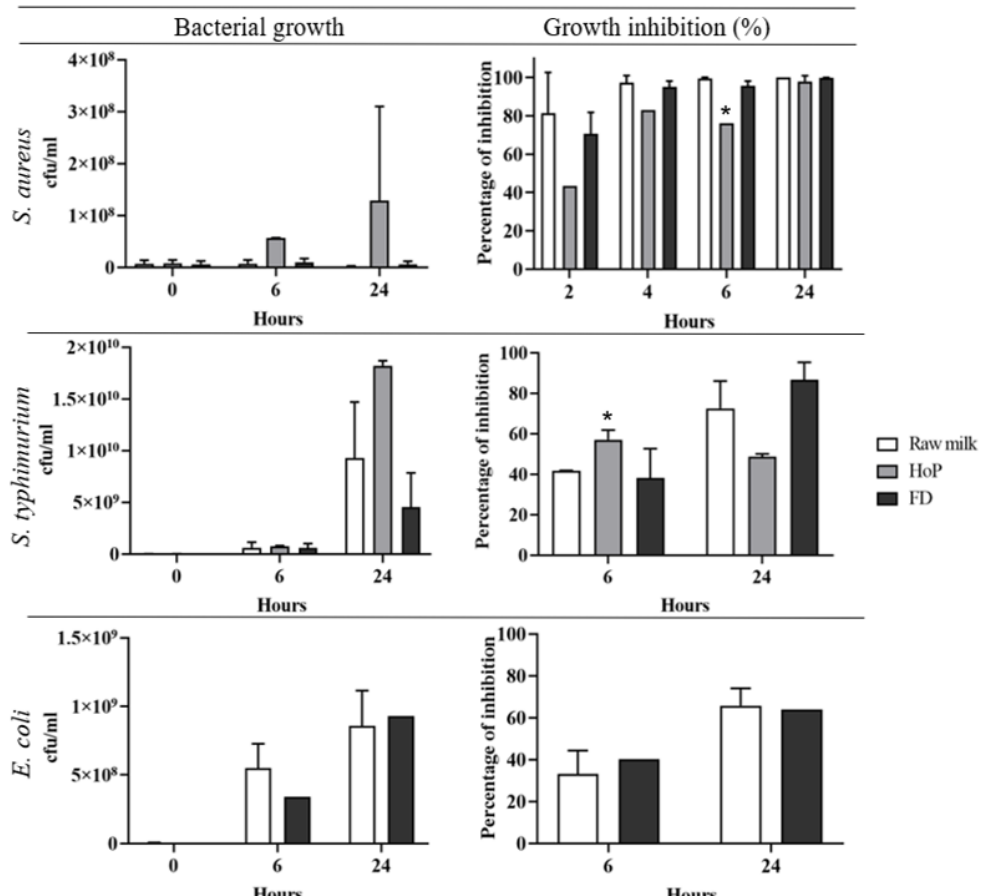
Figure 3. Bacterial growth and growth inhibition of inoculants in raw DHM and treated DHM. Treatments included freeze- drying (FD) and Holder pasteurisation (HoP). Inoculants included S. aureus , E. coli , and S. typhimurium , and 10 7 cfu/mL was used for each inoculant. Values are the means ± SD of 2 biological replicates. * Significant change in antimicrobial activity compared to raw DHM, p ≤ 0.05.